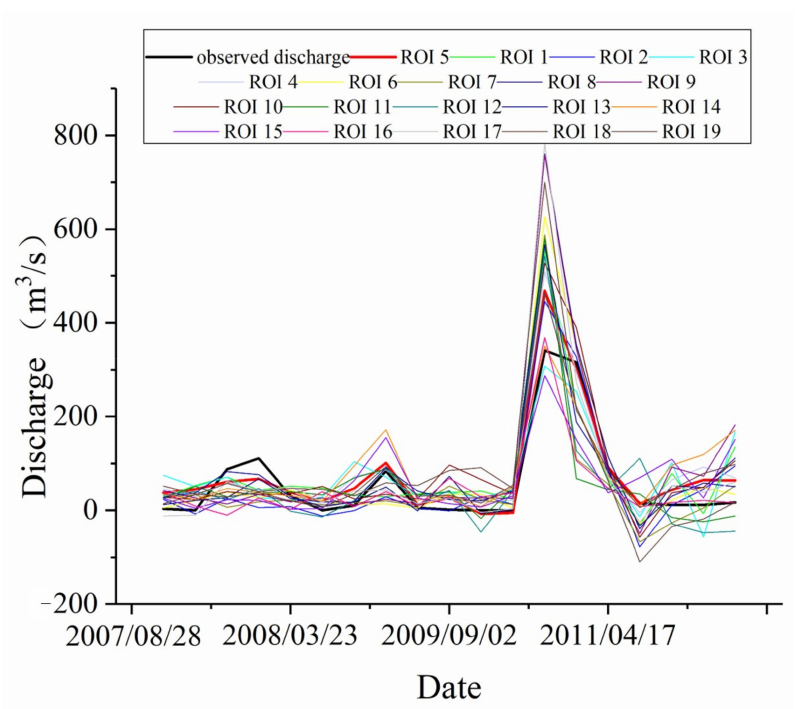
Figure A2. Estimated discharge using all 19 ROIs and observed discharge in the site near Gauge